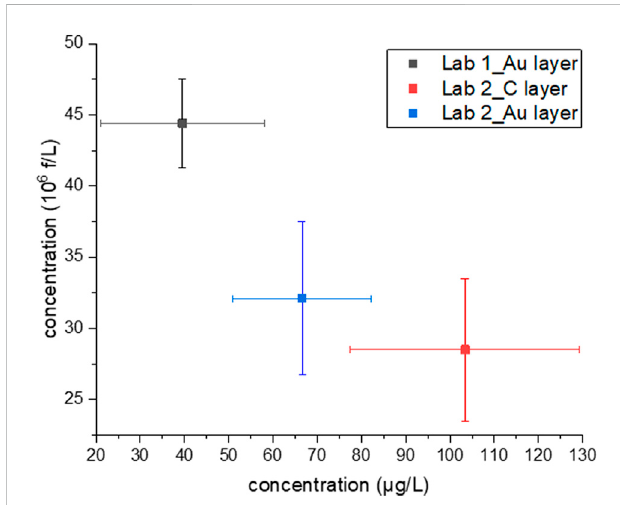
FIGURE 2 Concentrationvalues inmass(µg/L)vs.concentrationinnumberof fi bresperlitre(10 6 f/L)foundintheanalyticalsampleusingthreedifferent setups. Bars represent the 95% con fi dence limits. Only respirable fi bres are